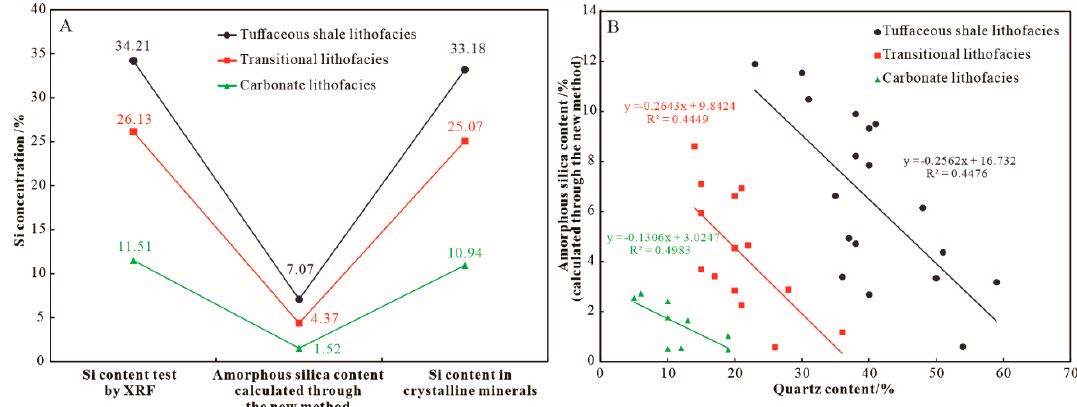
Figure 4. Diagrams showing ( A ) Si content tested by XRF, amorphous silica content calculated through the new method, and Si content in crystalline minerals. ( B ) cross plot of the amorphous silica content with crystalline quartz content in samples of the different lithofacies in the Lucaogou Formation.